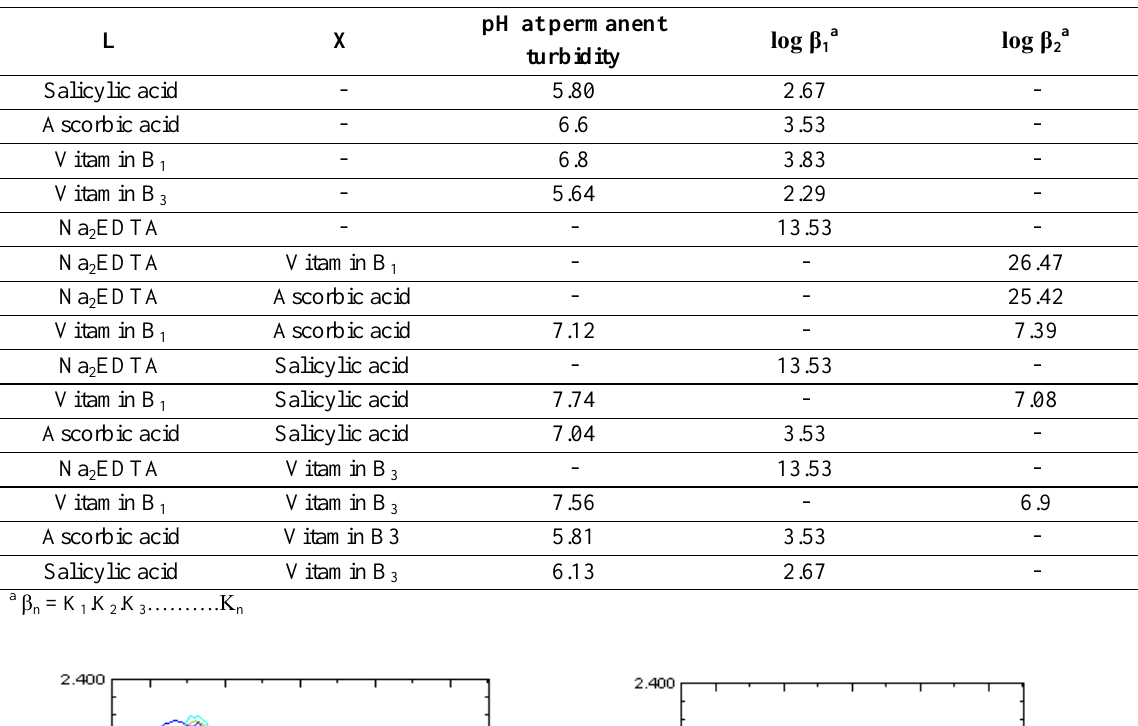
Table 2 : Overall stability constants (log β) for binary (1:1) and mixed ligand systems (1:1:1) at concentration 0.0025 M.